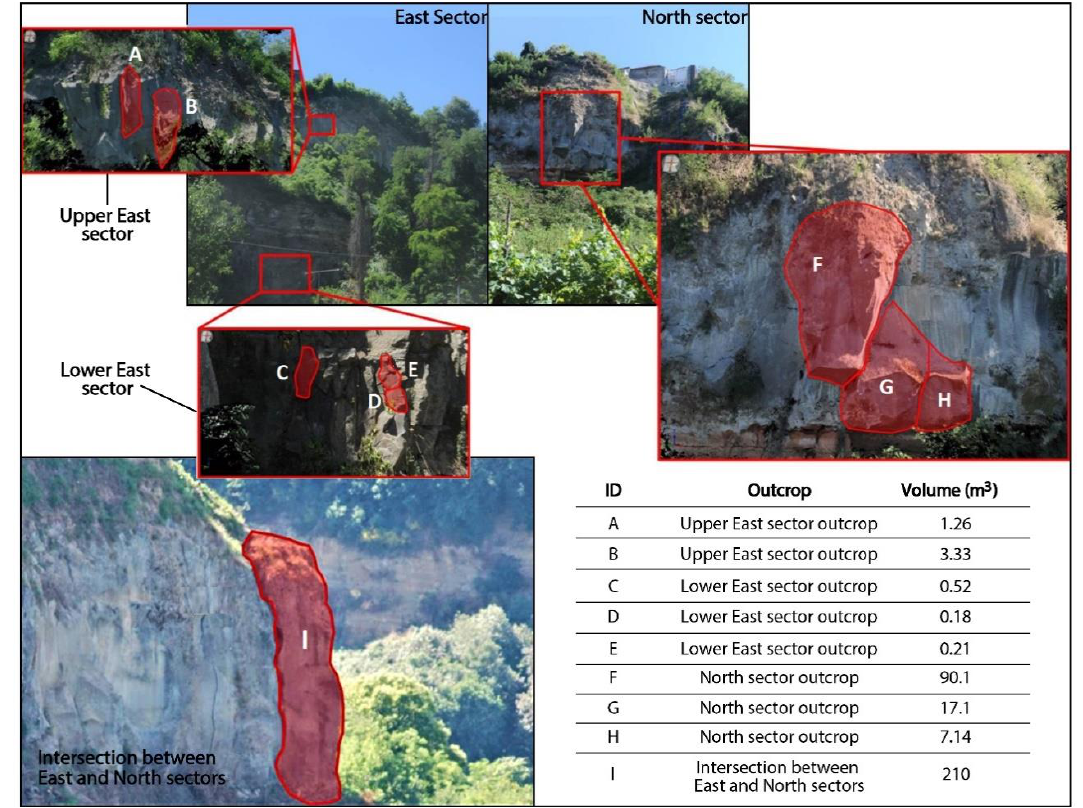
Figure 10. Rock blocks prone to failure on the Sugano cliff. The table reports the computed volumes of each rock block represented in the pictures.